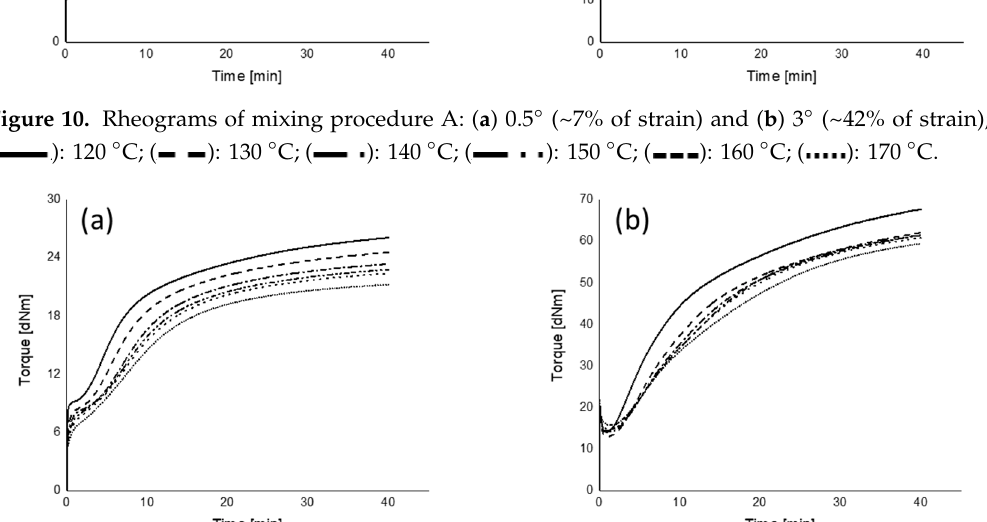
Figure 11. Rheograms of mixing procedure B: ( a ) 0.5° (~7% of strain) and ( b ) 3° (~42% of strain);